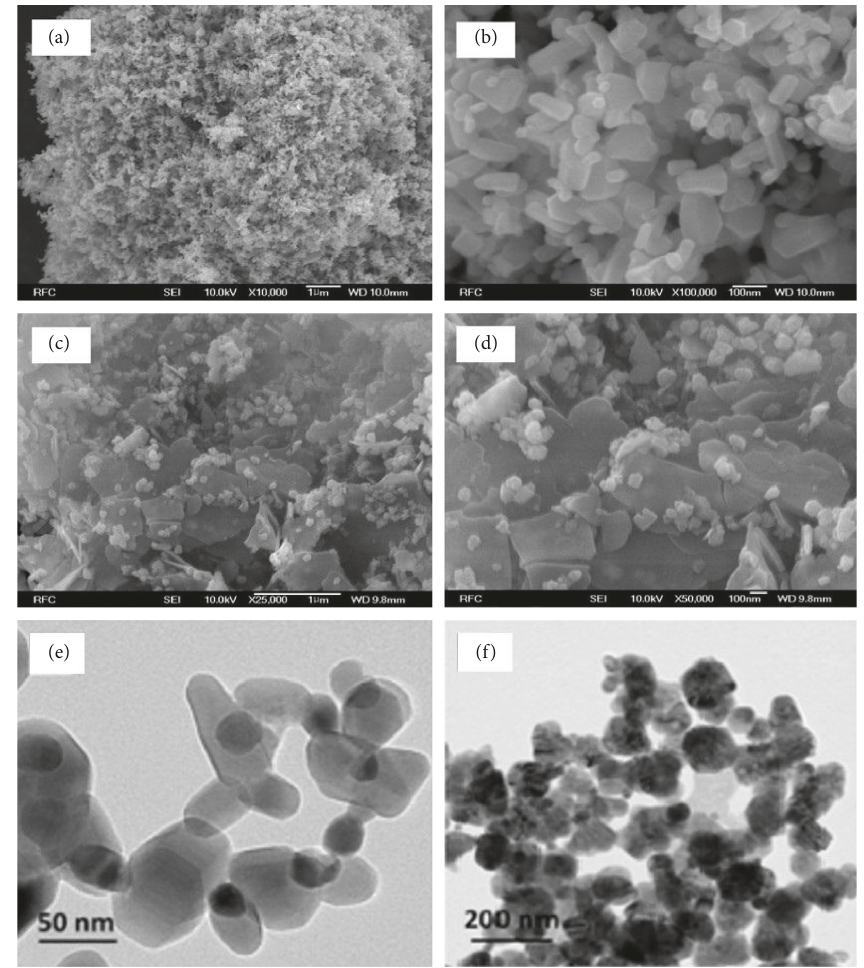
Figure 2: FE-SEM and TEM analyses of synthesized